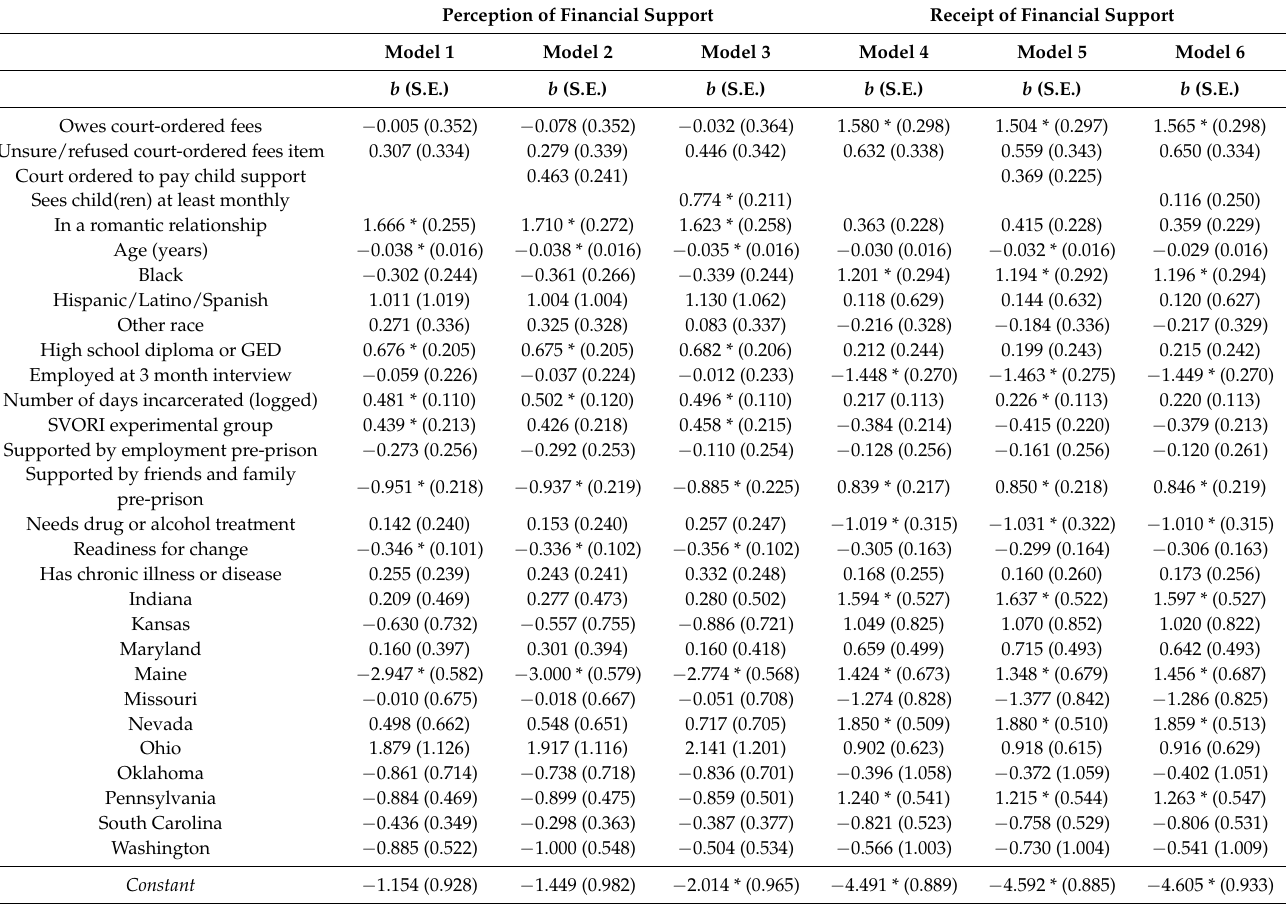
Table A1. Logistic Regression Models Predicting Perception of Financial Support and Receipt of Financial Support ( n =